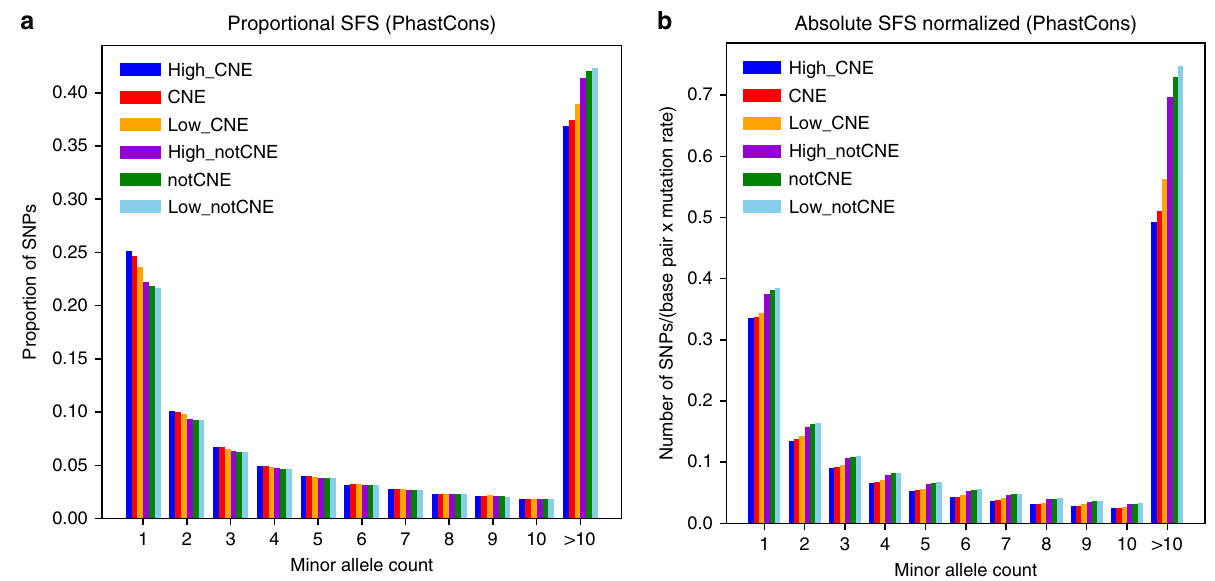
Fig. 3 CNEP score ’ s relationship to human variation. a The plot shows for PhastCons High_CNE, CNE, Low_CNE, High_notCNE, notCNE, and Low_notCNE bases, the proportional site frequency spectrum based on a set of 105 unrelated individuals in the YRI population in terms of number of SNPs per base pair eligible for a SNP to be called, normalized for the number of sites with a variant in each set (see “ Methods ” section). The last column includes all SNPs with minor allele count >10. b Similar plot to a , except showing the absolute site frequency spectrum per base pair eligible for a SNP to be called normalized by estimated mutation rates. Corresponding plots for additional constrained elements can be found in Supplementary Fig. 12 and plots controlling for difference in background selection can be found in Supplementary Fig. 13. Plots at higher thresholds of the CNEP score for notCNE bases can be found in Supplementary Fig. 14. Source data are provided as a Source Data fi